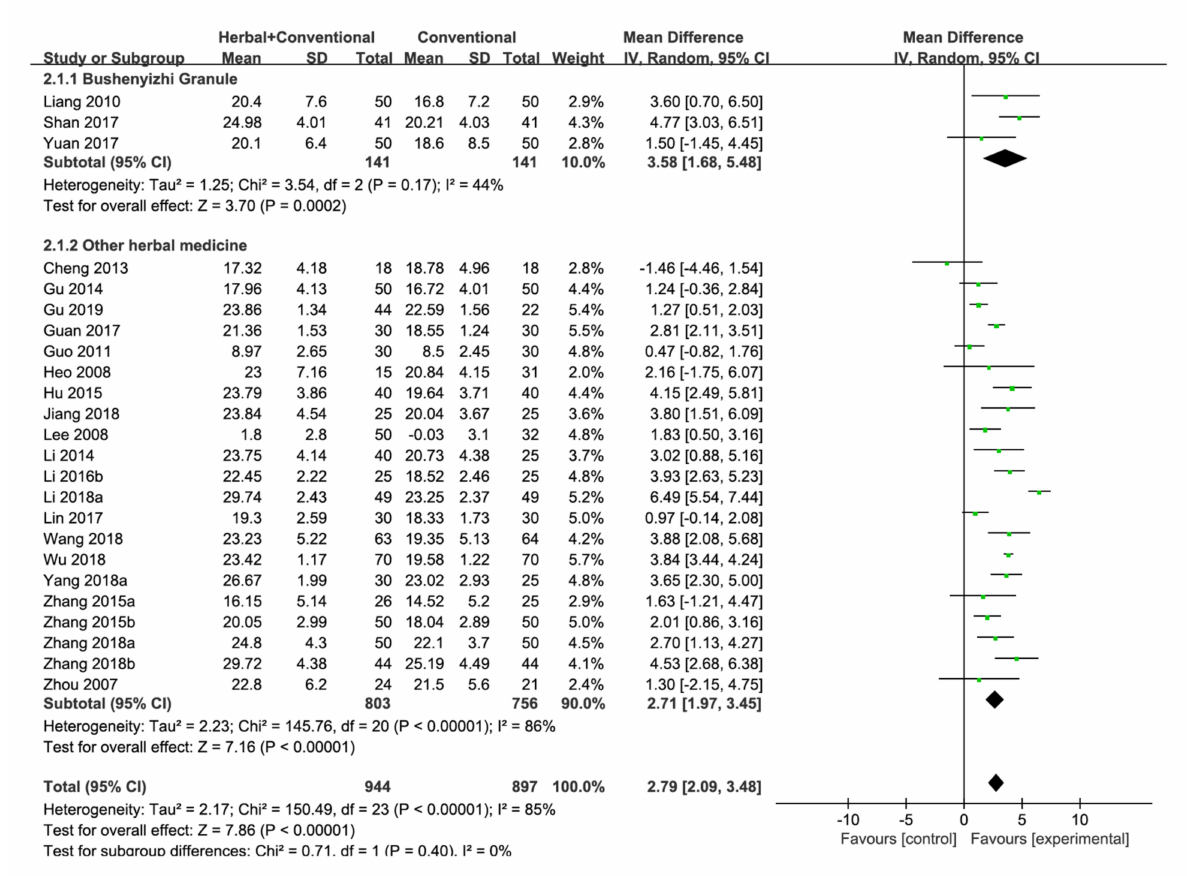
Figure 4. Forest plot for MMSE: Herbal medicine + conventional medicine vs. Conventional